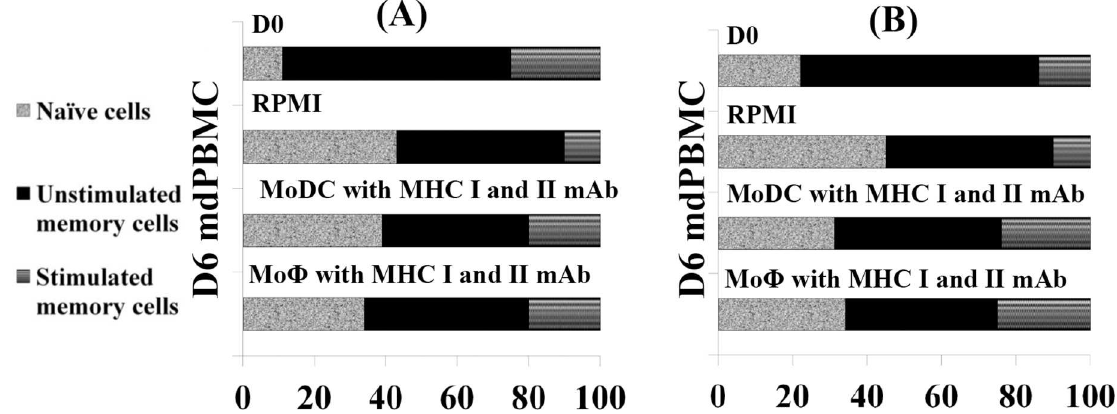
Fig 5. Demonstration showing response to Map/relA and MMP is MHC restricted. A. CD4 T cells in mdPBMC at T0 and after culture in RPMI for 6 days alone or cultured MoDC or MoM Φ pulsedwith Map/relA or MMP in medium containingmAbs to MHC I and MHC II. B . CD8 T cells in mdPBMC at T0 and after culture in RPMI for 6 days alone or cultured with MoDC or MoM Φ pulsed with Map/relA or MMP in medium containingmAbs to MHC I and MHC